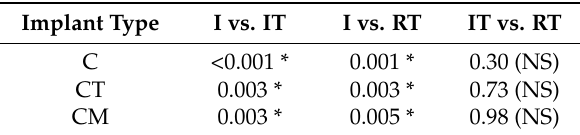
Figure 5. ( a ) Average I, ( b ) IT, and ( c ) RT values for the three types of implants (C, cylindrical; CT, cylindrical-tapered, CM, cylindrical-modified) and significance of the post-hoc Bonferroni paired comparison. Table 5. Statistical significance p of ANCOVA tests comparing the slopes of I–density, IT–density, and RT–density regression lines for each type of implant.